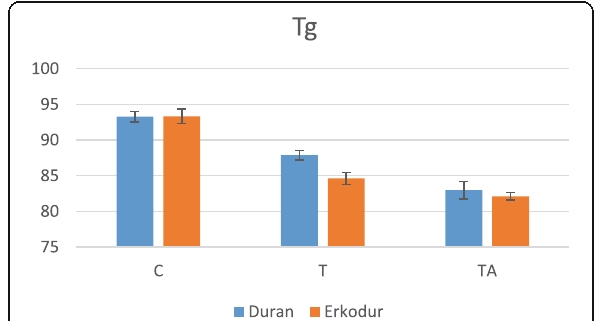
Fig. 5 Changes in dynamic Tg according to the material and groups